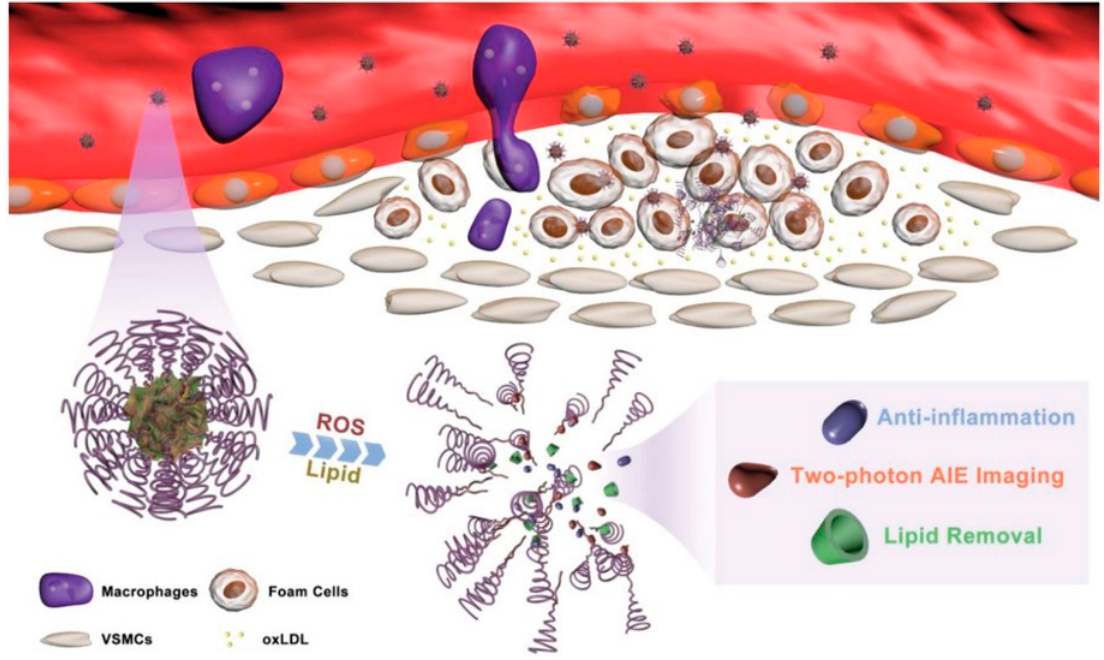
Figure 6. The ROS-responsive polymeric micelles release prednisolone in the lipid-rich environment of atherosclerotic plaque and allow for two-photon aggregation-induced emission imaging. Reproduced from Ma et al. [103], Open Access.